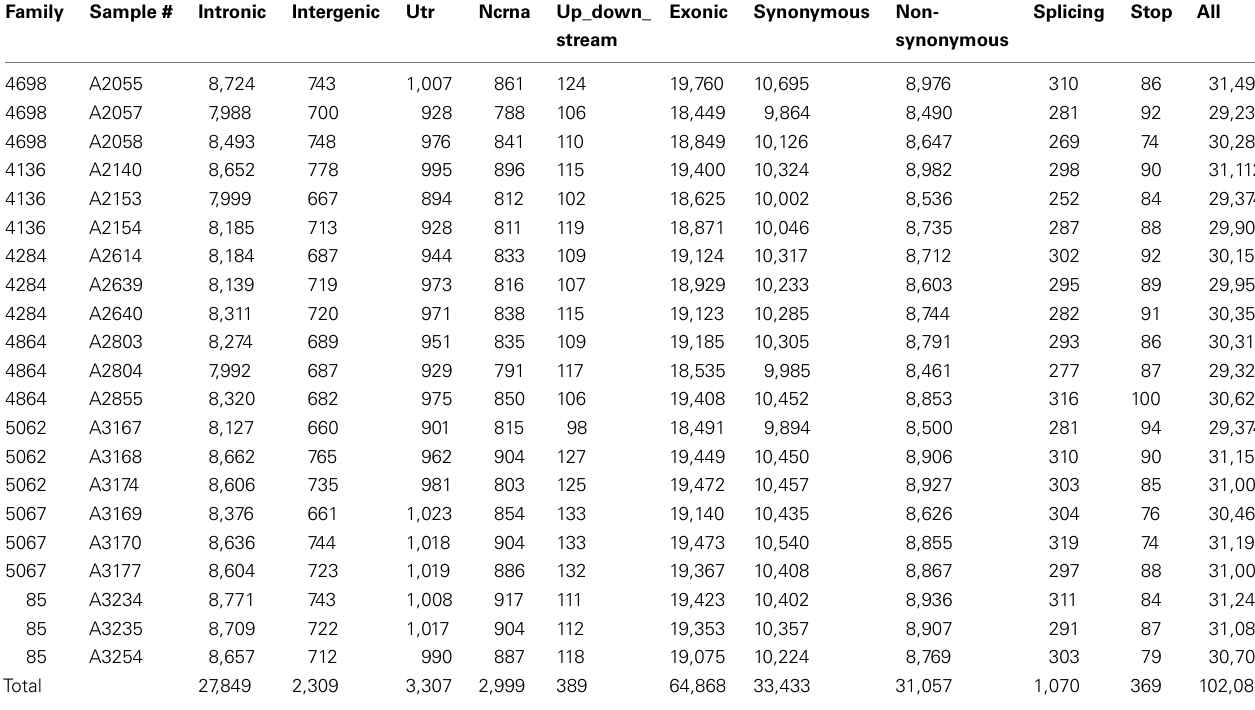
Table 3 | Number of variants within individual by category.